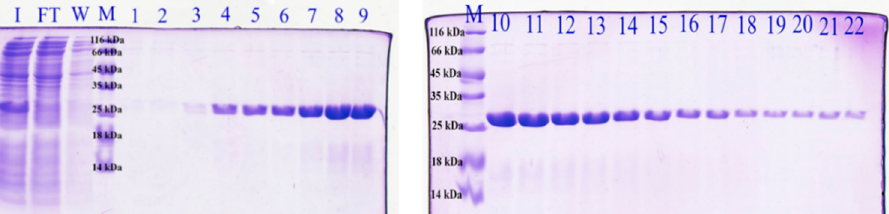
Figure 1. SDS-PAGE of scFvD2–5-HT1A. I, supernatant of the bacterial lysate; FT, column flow-through; W, column wash-out; M, weight marker; 1–22, number of fractions collected following affinity chromatography.